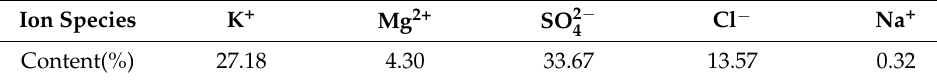
Table 2. Chemical titration data of MP sample.